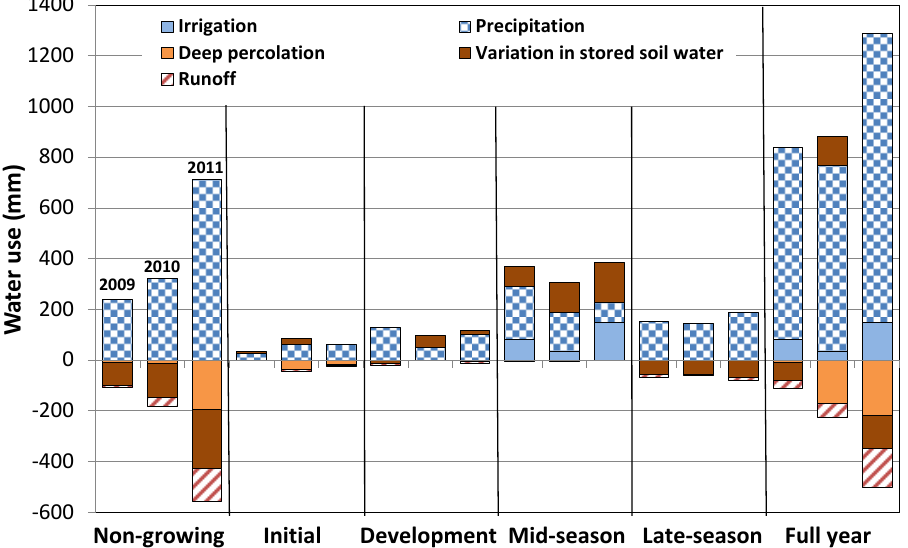
Figure 4. Simulated soil water balance components (all variables in mm) after proper model calibra- tion for the three studied years 2009–2011.